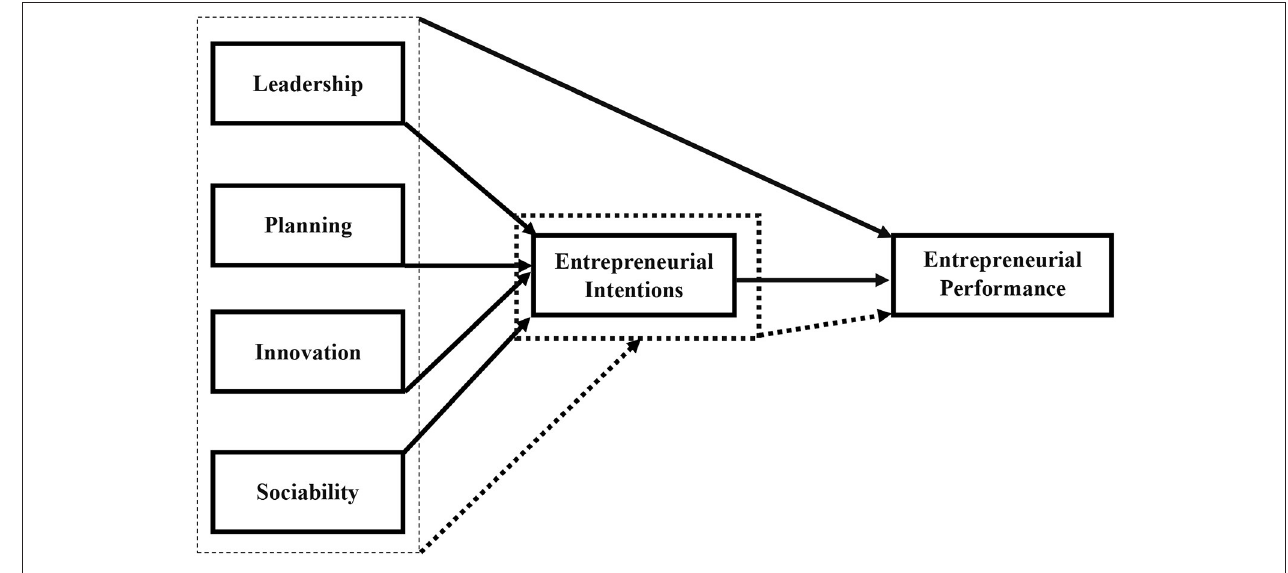
FIGURE 1 | Conceptual model.